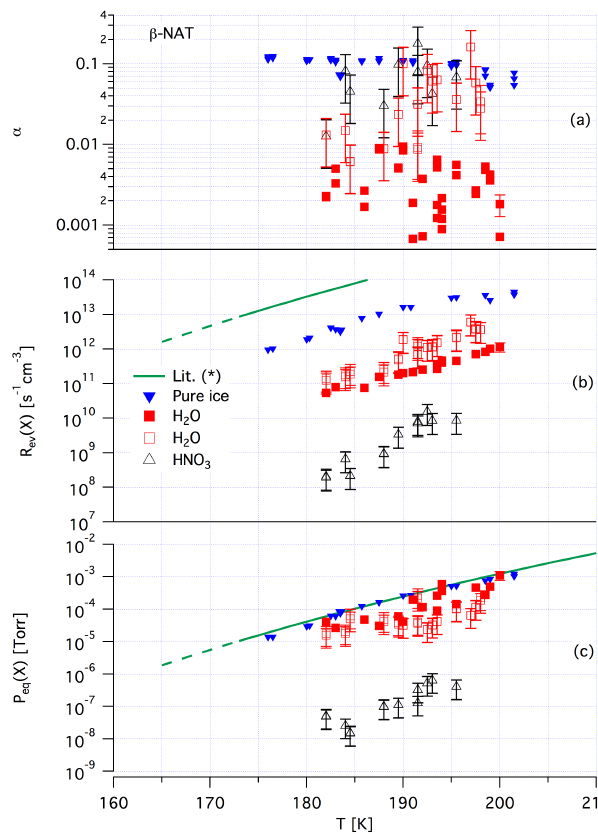
Figure 4. Synopsis of kinetic results for β -NAT using H 2 O as a probe gas in PV experiments and H 2 O and HNO 3 in two-orifice ex- periments. Full symbols represent PV experiments, and empty sym- bols represent TO experiments. The different symbols are coded in panel (b) . The calculated relative error for PV experiments is 30%, whereas for TO experiments we estimate a relative error of 60%. Examples of the amplitude of the errors are reported for selected points. The green line shows results from Marti and Mauersberger